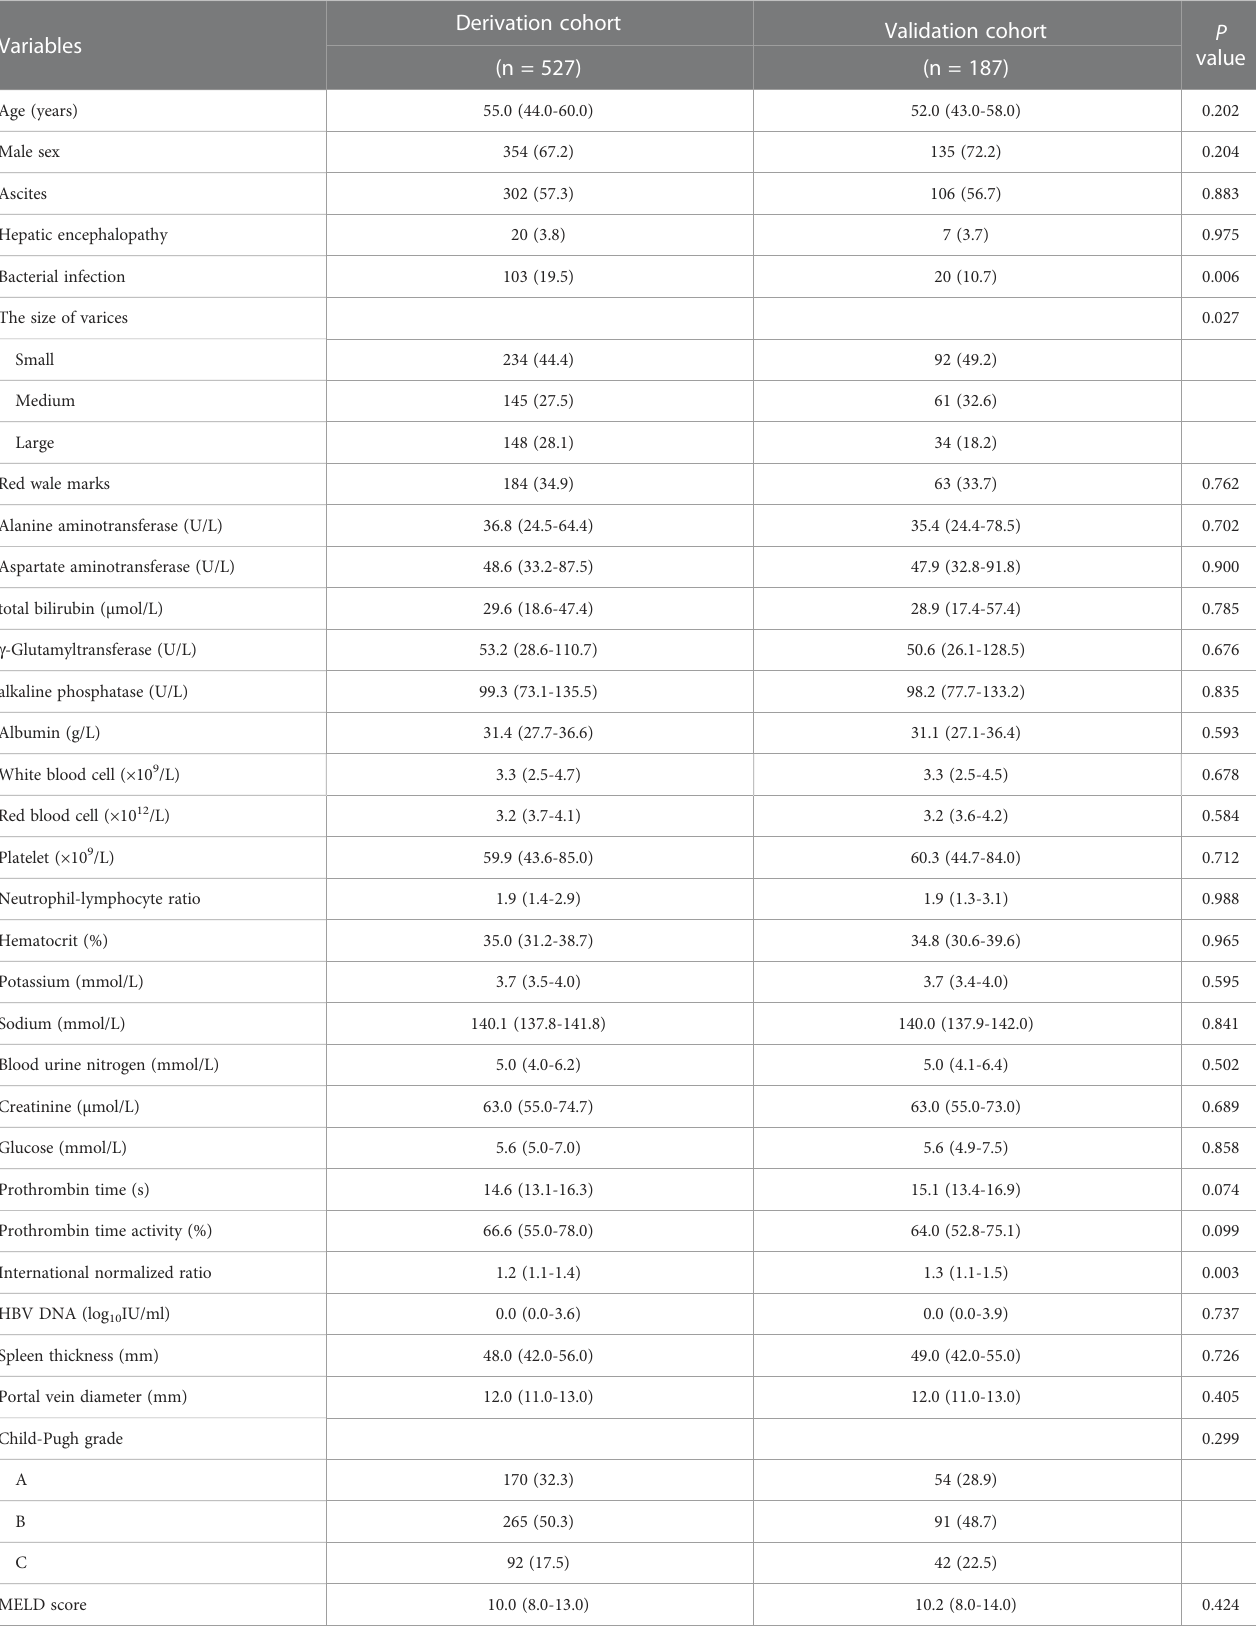
Table 1 Baseline characteristics of the patients in the derivation and validation